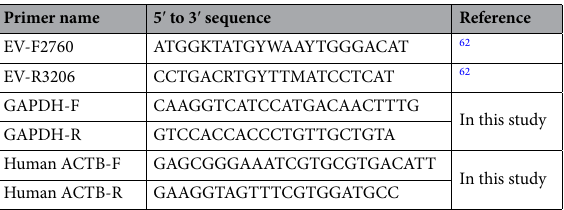
Table 3. Primers used for